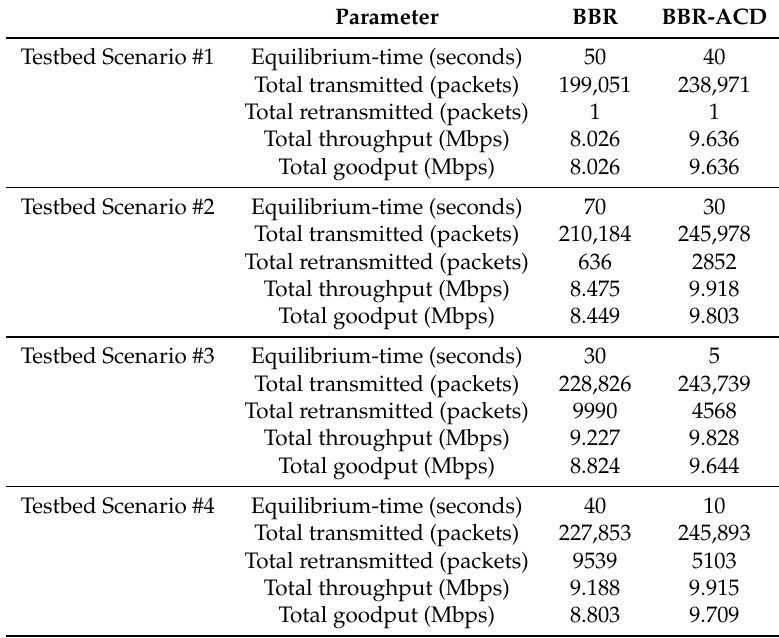
Table 2. Performance comparison between BBR and